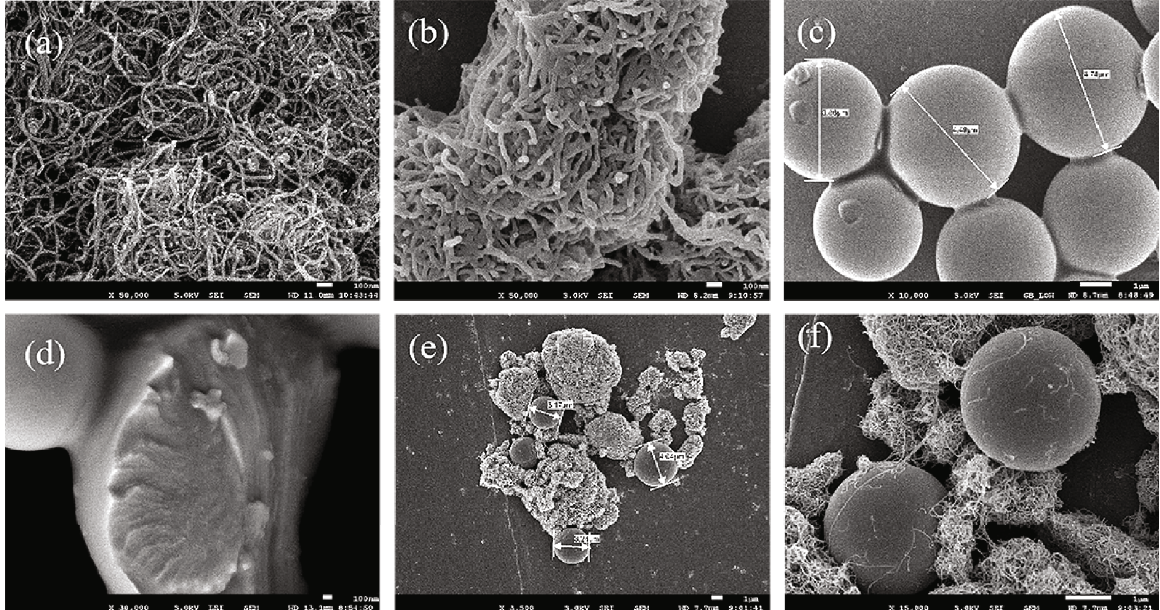
Figure 3: (a) SEM images of raw CNTs. (b) SEM images of CNTs-PDA. (c) SEM images of PSQ-SH particle. (d) SEM images of crushed PSQ-SH particle. (e, f) SEM images of